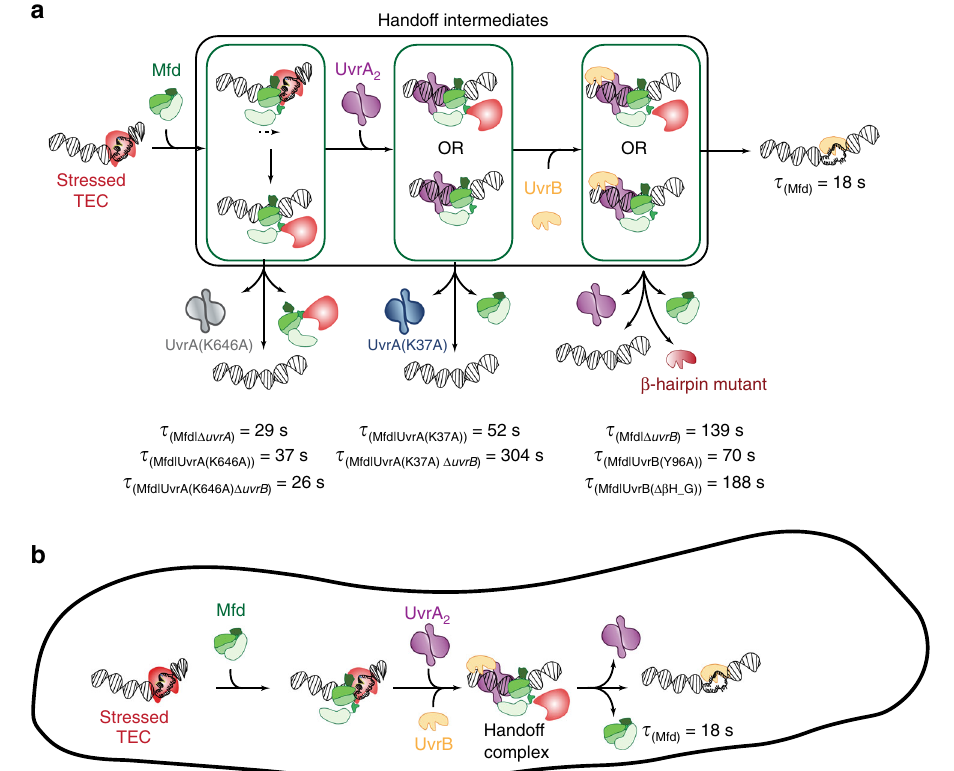
Fig. 5 Model for interactions of Mfd, UvrA and UvrB at sites of stressed TECs in cells. a In cells, Mfd is normally auto-inhibited and does not stably interact with DNA. Binding to stressed TECs via its RNAP interacting domain leads to release of inhibition and a large conformational change in the protein. Following this, the motor domain engages DNA on the upstream edge of the transcription bubble and subsequent ATP hydrolysis leads to either transcription reactivation/termination. Mfd continues to translocate on dsDNA after remodeling the RNAP. Meanwhile, the UvrB homology module of Mfd is exposed permitting recruitment of UvrA. ATP hydrolysis at UvrA ’ s distal ATPase site is necessary for this engagement. Engagement with UvrA 2 leads to arrest of translocation. Further, recruitment of UvrB (either sequentially as shown, or simultaneously with UvrA 2 ) to the site leads to formation of the Mfd- UvrA-UvrA-UvrB handoff complex. Subsequent ATP hydrolysis at UvrA ’ s proximal ATPase site results in loading of UvrB on the DNA. Successful engagement of UvrB with the DNA via its β -hairpin is necessary for completing the handoff, culminating in dissociation of Mfd and UvrA 2 from the site. b Facilitated dissociation model operates inside cells resulting in the simultaneous loss of UvrA 2 and Mfd from the site of transcriptional